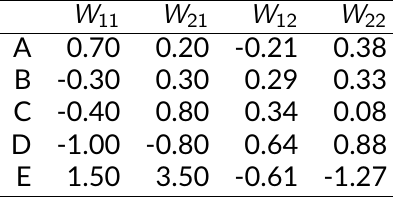
Table SI5 – Two-gene example networks. The five two-gene networks detailed in Fig- ure 2 and Sup. Figure